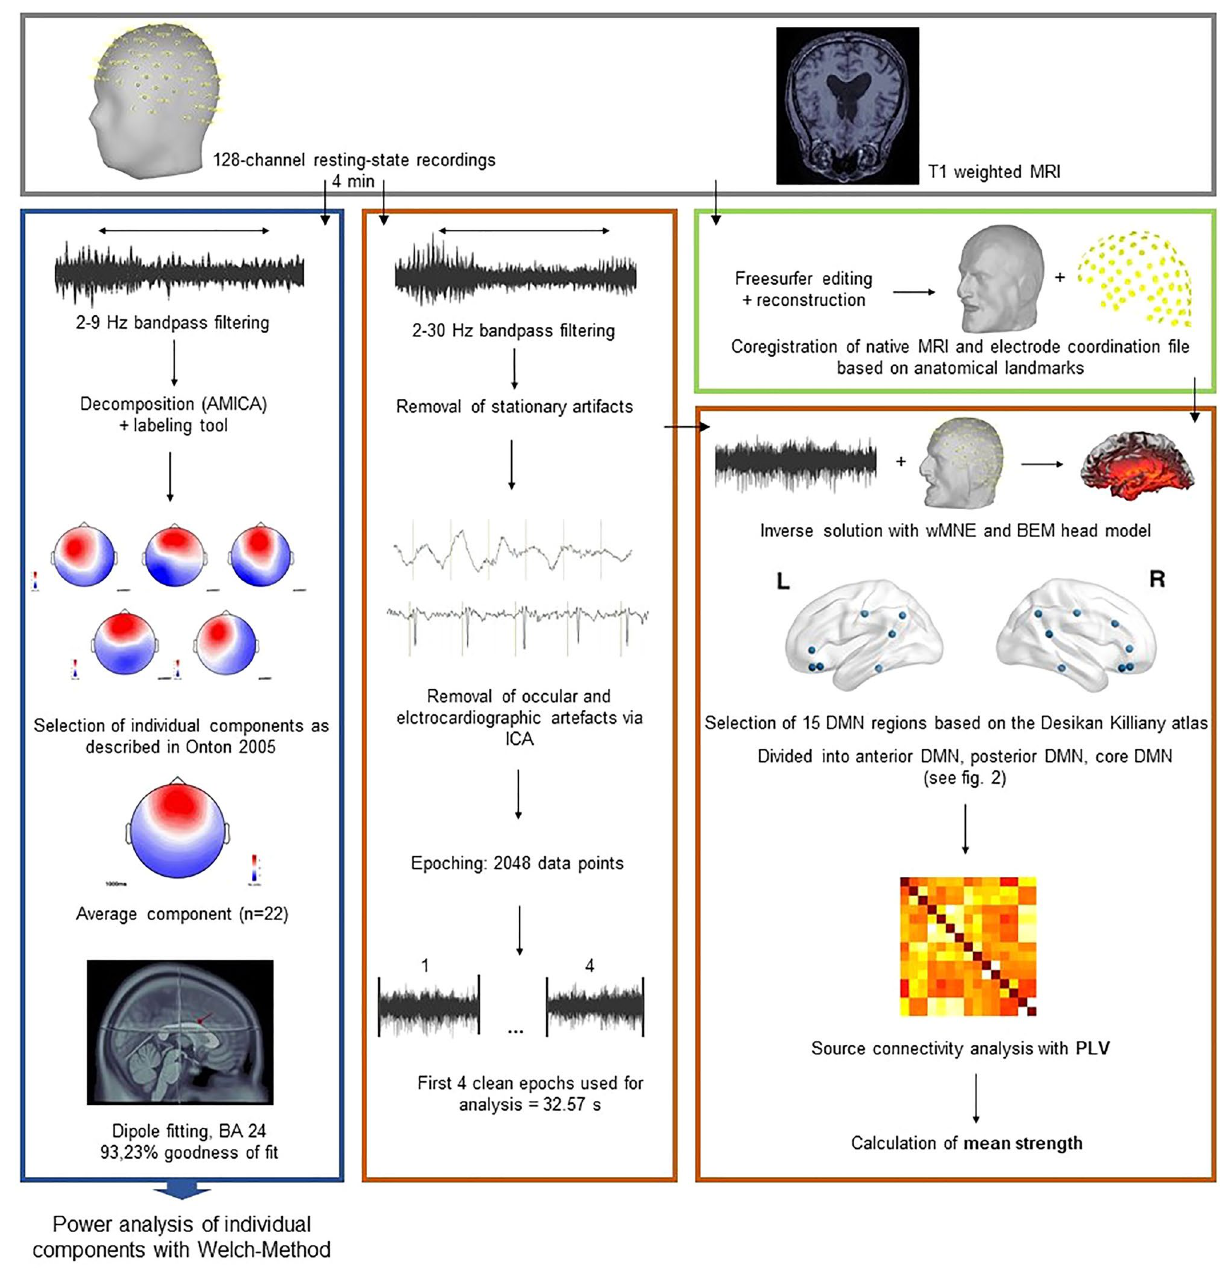
Figure 2. Data processing stream overview adapted from Kabbara et al. 41 . Blue box: Determination of frontal midline theta with independent component analysis. The average component was localized within Brodman Area (BA) 24. Power spectrum density (Welch method) was used to extract relative power over the whole epoch. Orange box: Preprocessing steps and selection of epochs for source connectivity and power analysis in the Default Mode Network (DMN). Green box: Preprocessing of native MRI and co-registration with the electrode coordinates. AMICA adaptive mixture independent component analysis, ICA independent component analysis, wMNE weighted minimum norm estimation, BEM boundary element model, PLV phase locking